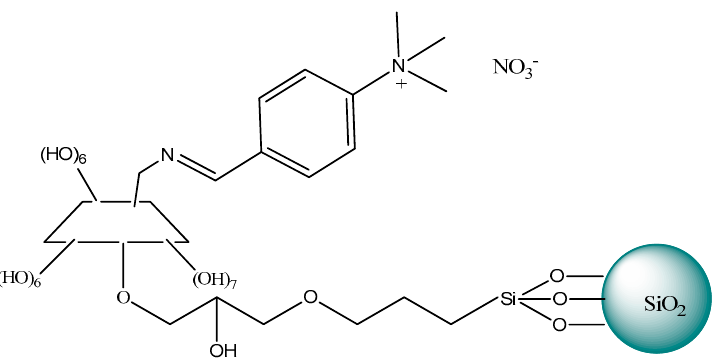
Figure 15. Structure of mono(6-deoxy-imino)-beta-cyclodextrins chiral stationary phases (adapted from Li, 2014) [204].